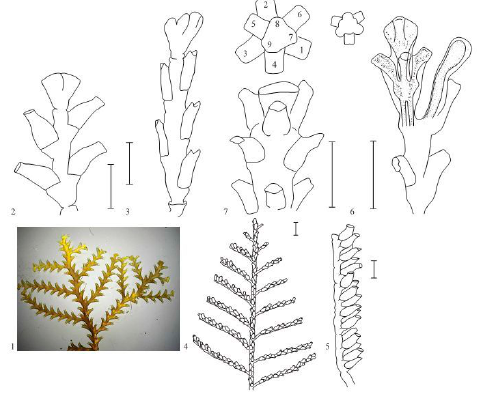
Figure 9. The most interesting morphological variations which looks like similar modules in other genera of hydroids. 1—Alternate hydrotheca pattern in the shoots and branches of Abietinaria abi- etina (L., 1758) (bar—1 mm); 2—division of the growth tip of the A. abietina shoot into two rudiments (bar—1 mm); 3—laying of a lateral branch at the growth tip of the shoot of Sertularia suensoni Levinsen, 1913 (bar—0.5 mm); 4—lateral branch of Hydrallmania falcata (L., 1758) (bar—1 mm); 5—a fragment of the H. falcata branch, lateral view (bar—0.5 mm); 6—the morphotype I-70(27) of D. pumila (bar—1 mm); 7—the apical part of the lateral branch of Pericladium mirabilis (Verrill, 1873) (bar—1 mm).